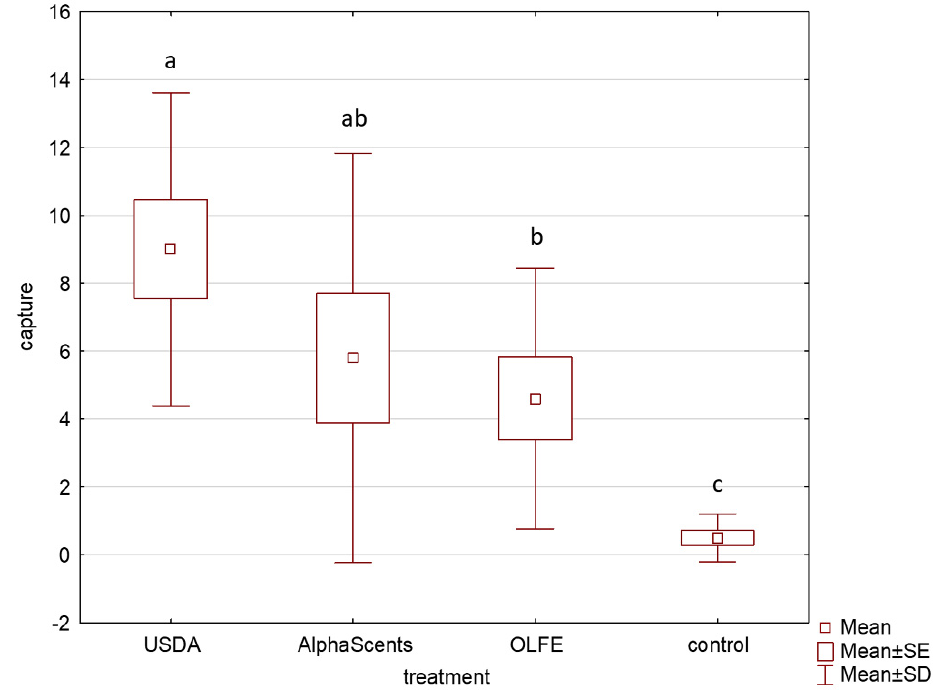
Figure 2. Number of male CPB captured with OLFE (Eppendorf formulation), two sources of pheromone lure (USDA and Alpha Scents, Inc.), and unbaited control traps in a four-week field test. Ten replicates per treatment were used in this experiment. Boxes presenting different letters are significantly different.